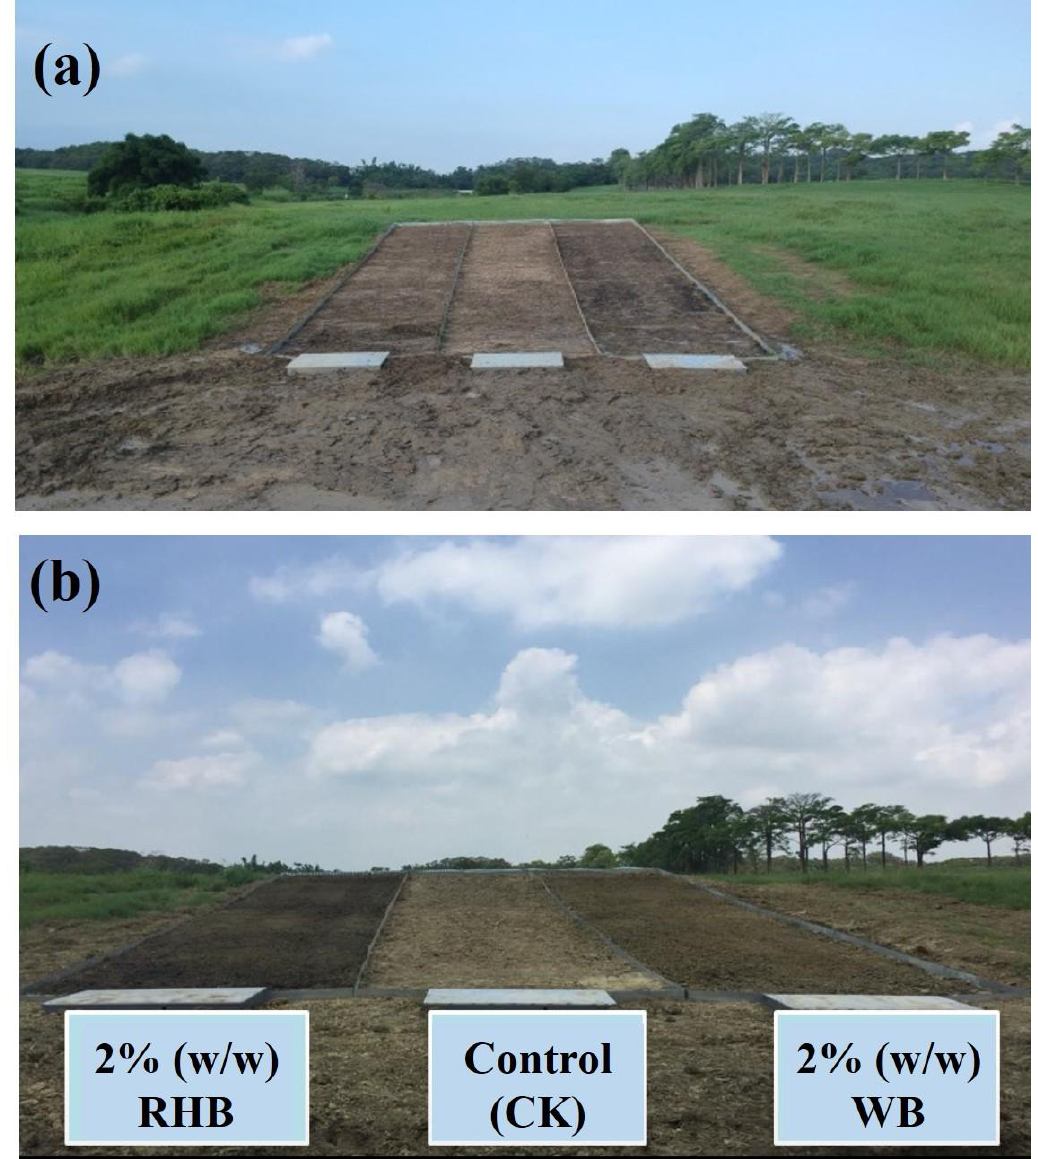
Figure 3. Standard erosion plot (a) and representative biochar application subplots